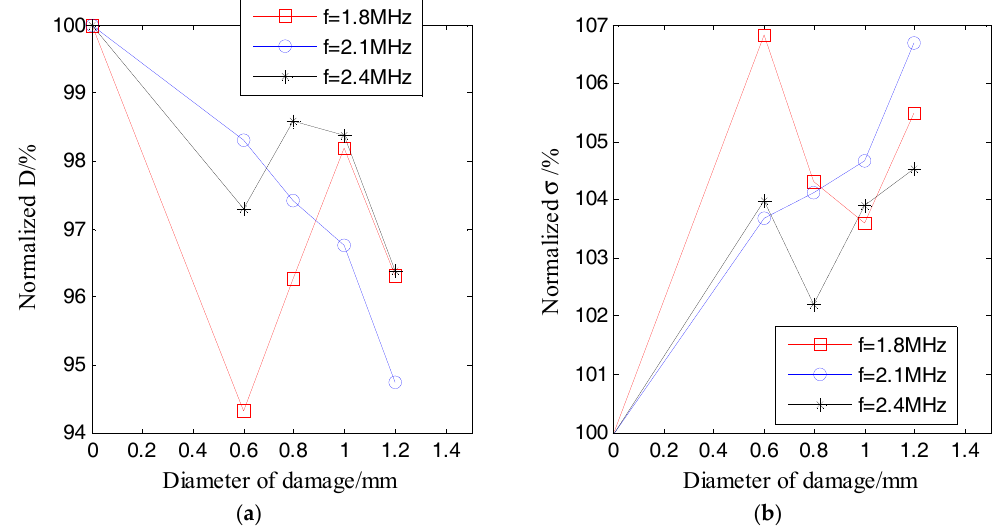
Figure 13. Normalized ultrasonic energy coefficients of damage D2 versus the damage size under different excitation pulses: ( a ) ultrasound energy diffusion coefficient; ( b ) ultrasonic energy dissipation coefficient.